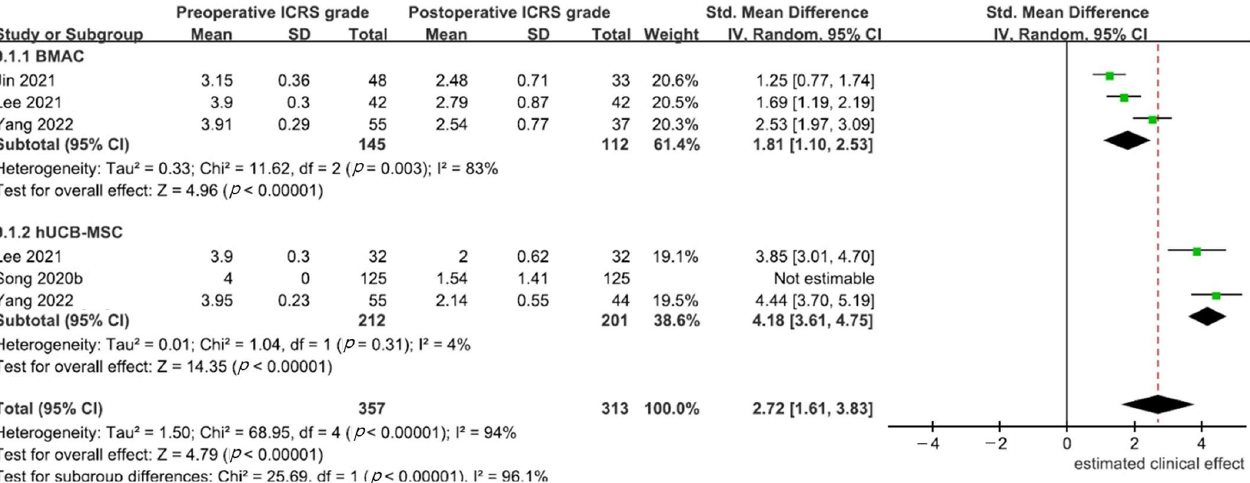
Figure 5. Estimated clinical effects of bone marrow aspirate concentrate (BMAC) and human umbilical cord blood-derived mesenchymal stem cells (hUCB-MSCs) in knee osteoarthritis (OA) patients treated with high tibial osteotomy (HTO) based on second-look arthroscopic articular cartilage status